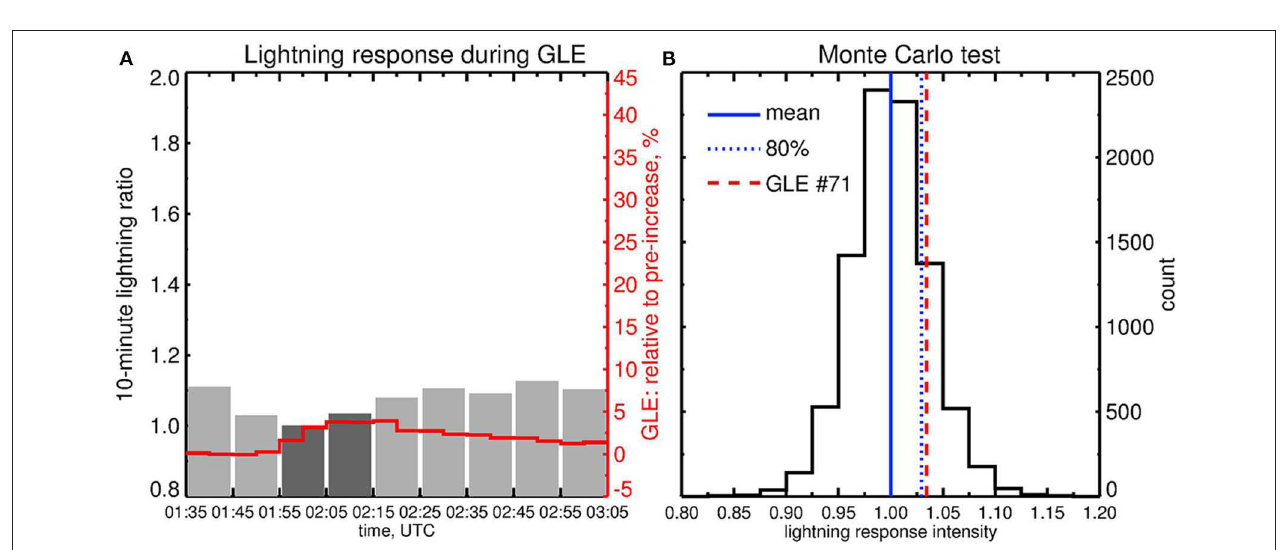
FIGURE 3 | (A) Lightning response during GLE #71 (May 17, 2012). (B) Results of the Monte Carlo test in 2012. The blue dotted line represents the value at 80% confidence level.